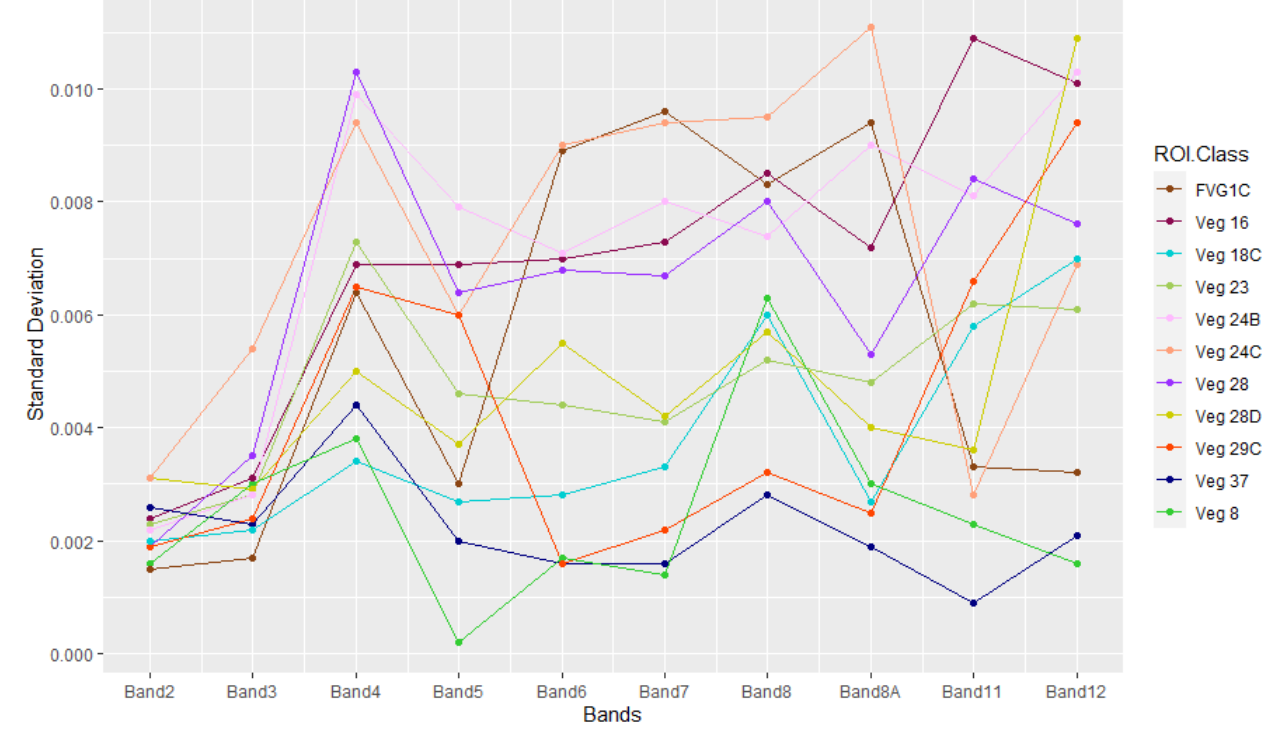
Figure 5. Standard deviation of the pixel bands 3, 4, 8 and 11 chosen for feature identification and suitable discrimination between vegetation communities, and ultimately selecting training Regions of Interest (ROI) for the classification classes committed to the classifier. of Interest (ROI) for the classification classes committed to the